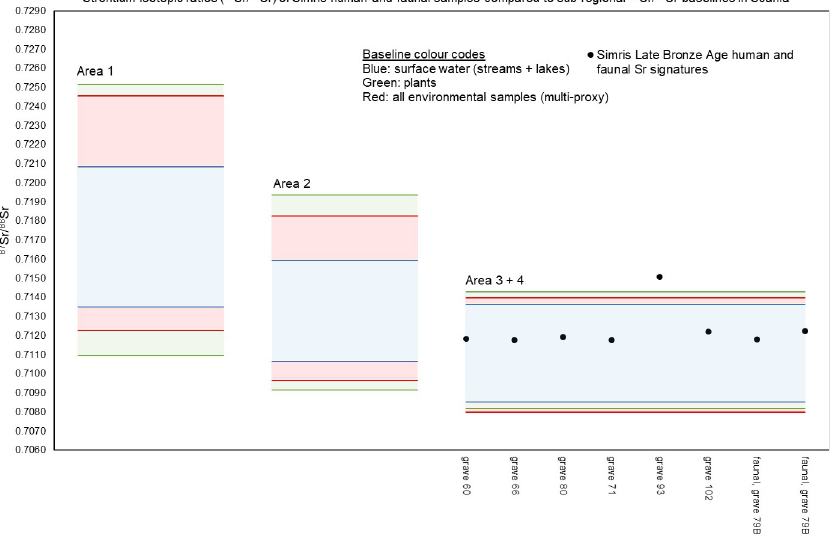
Fig 9. Strontium isotopic ratios of cremated human and faunal samples from the Late Bronze Age cemetery Simris II, shown together with sub-regional, multi- and single-proxy baselines from Scania. The Simris II cemetery is located within Area 3–4 (Fig 6). Results and details of the samples are found in Table